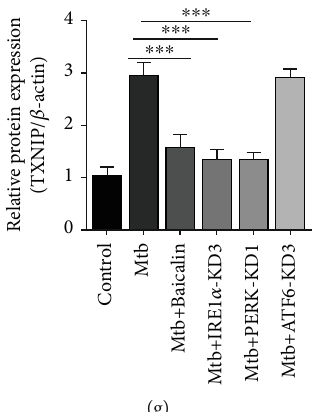
Figure 4: Baicalin attenuates TXNIP via inhibiting endoplasmic reticulum stress in Mtb-infected macrophages. (a, c) Levels of BIP and CHOP protein were tested by western blotting measurement in RAW264.7 cells. (b, d) Levels BIP and CHOP protein were measured by western blotting in primary peritoneal macrophage cells. (e) Transfection e ffi ciency of siRNAs was measured by western blotting analysis in RAW264.7 cells. (f) Western blotting analysis of TXNIP expression after siRNAs of IRE1 α , PERK, and ATF6, respectively, in RAW264.7 cells. Data are shown as mean ± SD of three independent experiments. ∗ p < 0 : 05 ; ∗∗ p < 0 : 01 ; ∗∗∗ p < 0 : 001 ; NS: nonsigni fi